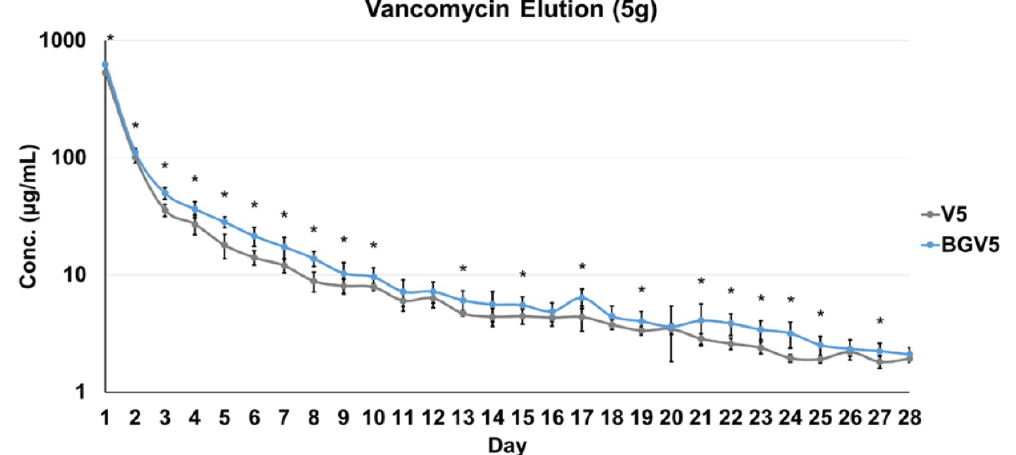
Figure 2. Vancomycin concentration of daily eluate for 5g groups (n=10) on a log scale . An asterisk (*) above a data point set indicates a significant difference (p<0.05) between BGV5 and V5. Error bars indicate ± one standard deviation from the mean.